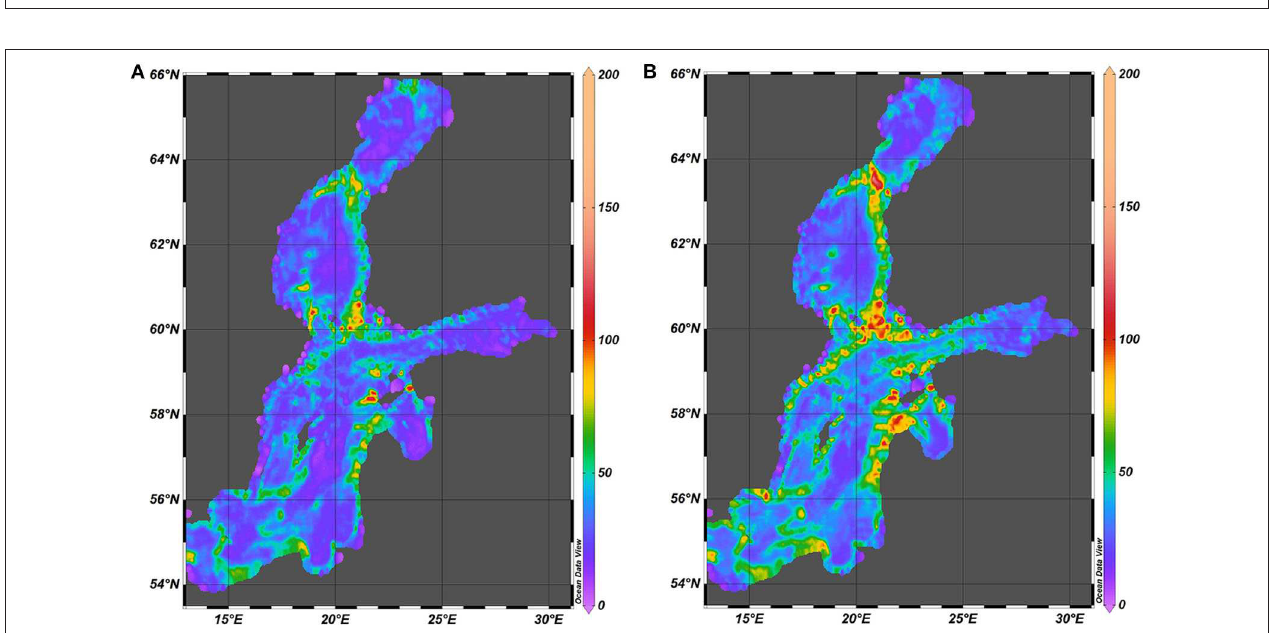
FIGURE 8 | Spatial distribution of the combined spectral amplitude (Equation 4) of vertical fluctuations of pycnocline (m) in 1961–1965 (A) and 2000–2005 (B) . The diagrams show this quantity for the main pycnocline in regions where it exists and the spectral amplitude for the seasonal pycnocline in the rest of the sea. The maximum value is 4.5 but for better readability the scale is limited to 2.25.